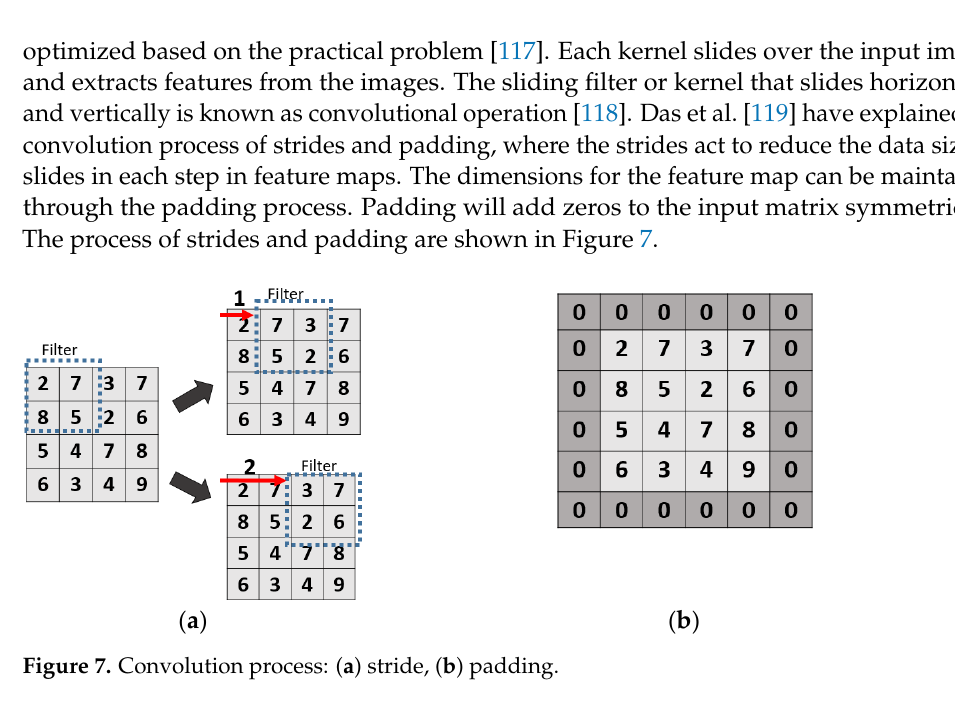
11 of 38 Figure 6. Basic architecture of CNN.